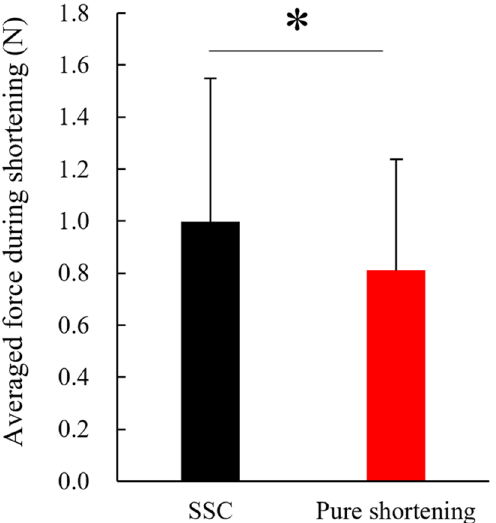
Figure 6. Comparison of the SSC effect attained between SSC and pure shortening conditions (N = 9) (means ± SD). * indicates the significant difference between